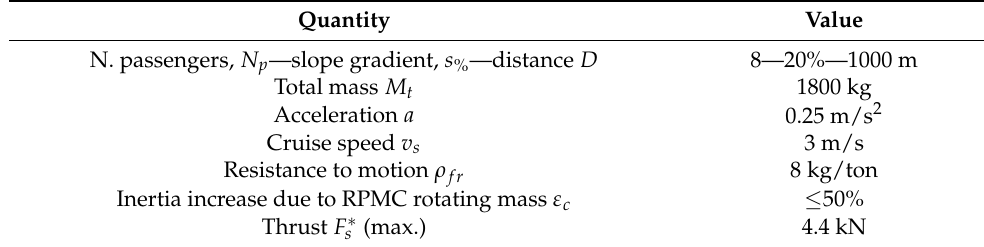
Table 1. Main application